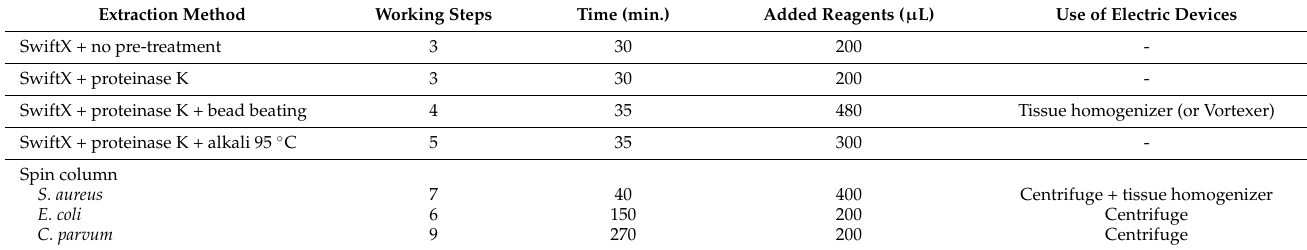
Table 3. Number of working steps, time (min.), added volume of reagents (in µL) and the number of additional electric devices for di ff erent extraction protocols for S. aureus , E. coli and C. parvum . Extraction Method